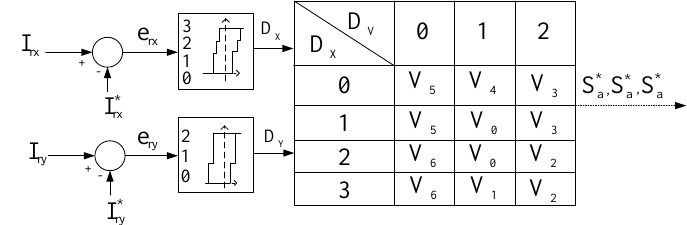
Figure 16. Variable-band vector-based hysteresis current regulator (VBHCR) employed in RSC control structure representation.